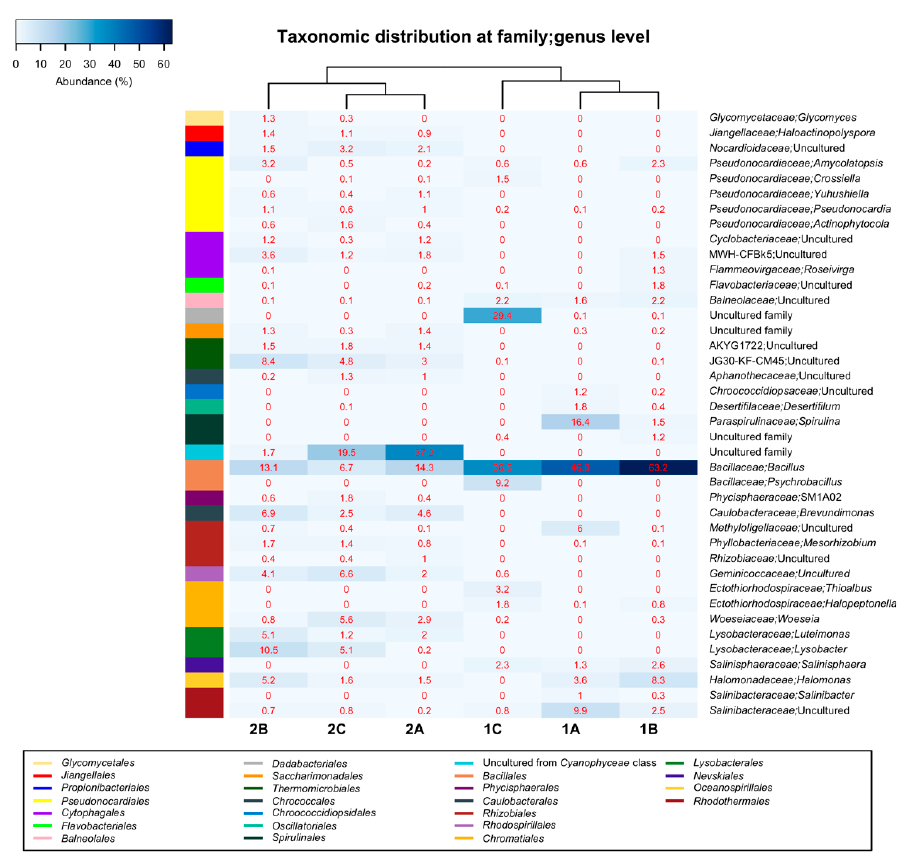
Figure 5. Heat-map analysis of Nerja Cave biofilms. Taxonomic identifications of Bacteria at families and genera level. The groups are described in the right column and their respective abundances included in the boxes.